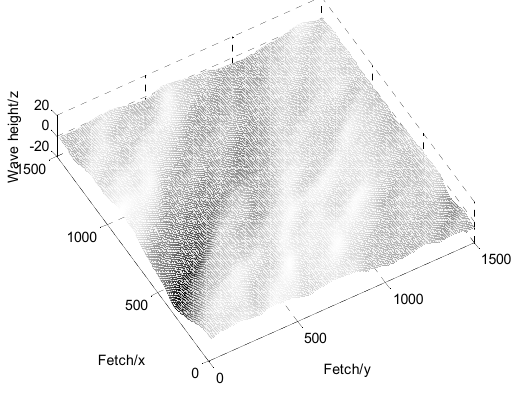
Figure 6. Simulation of 2-D sea surface by fractal method with wind speed 11 km/h, fetch 15 km, wind direction 320° and fractal dimension 1.5.